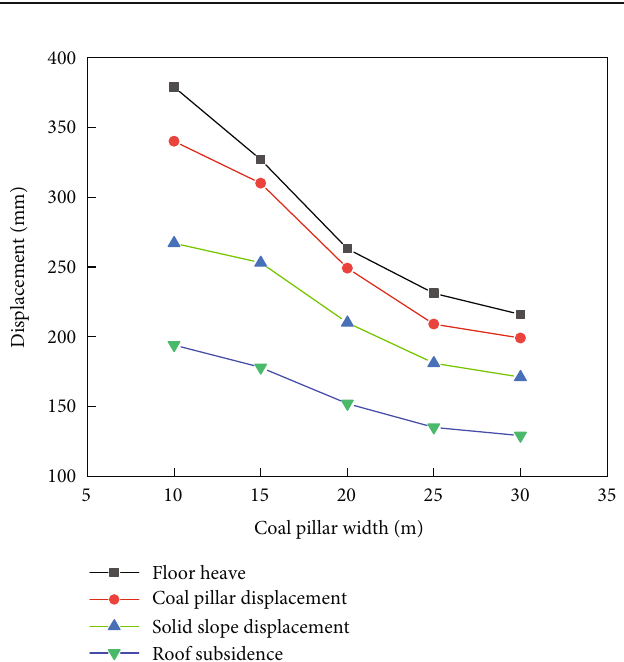
Figure 10: Deformation of roadway with di ff erent coal pillar widths.